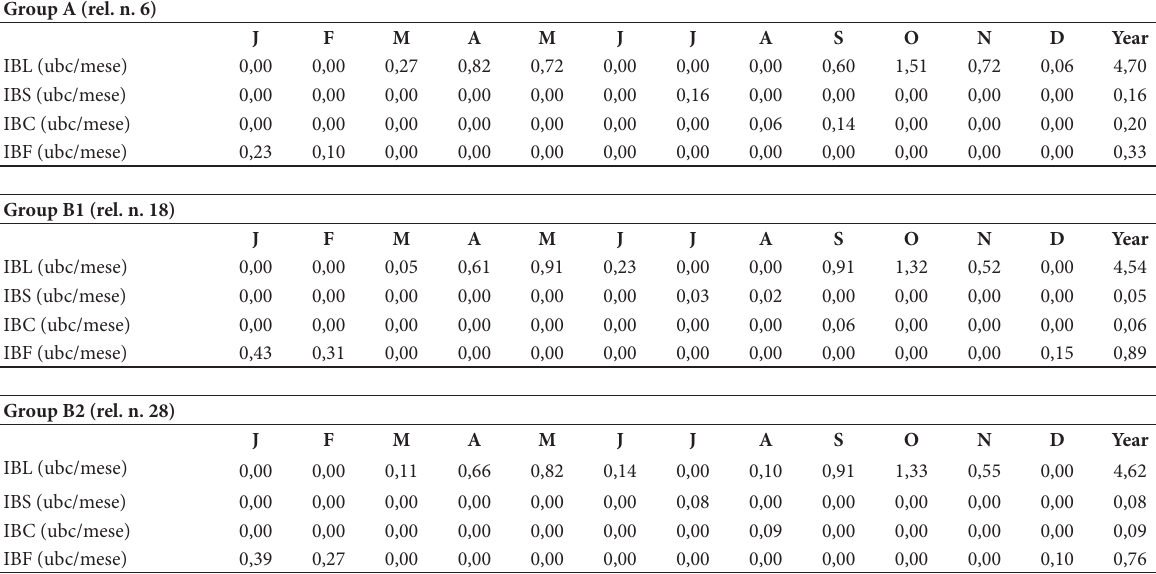
Table 2. Values of the Bioclimatic Intensities (IB) according to Montero de Burgos and González Rebollar, for the sites represen- tative of the three main groups of the dendrogram, A, B1 and B2 (that is, the sites where the holotypes of the three corresponding syntaxa were performed). IBL = Free Bioclimatic Intensity; IBS = Dry Bioclimatic Intensity; IBC = Conditional Bioclimatic Intensity; IBF = Cold bioclimatic